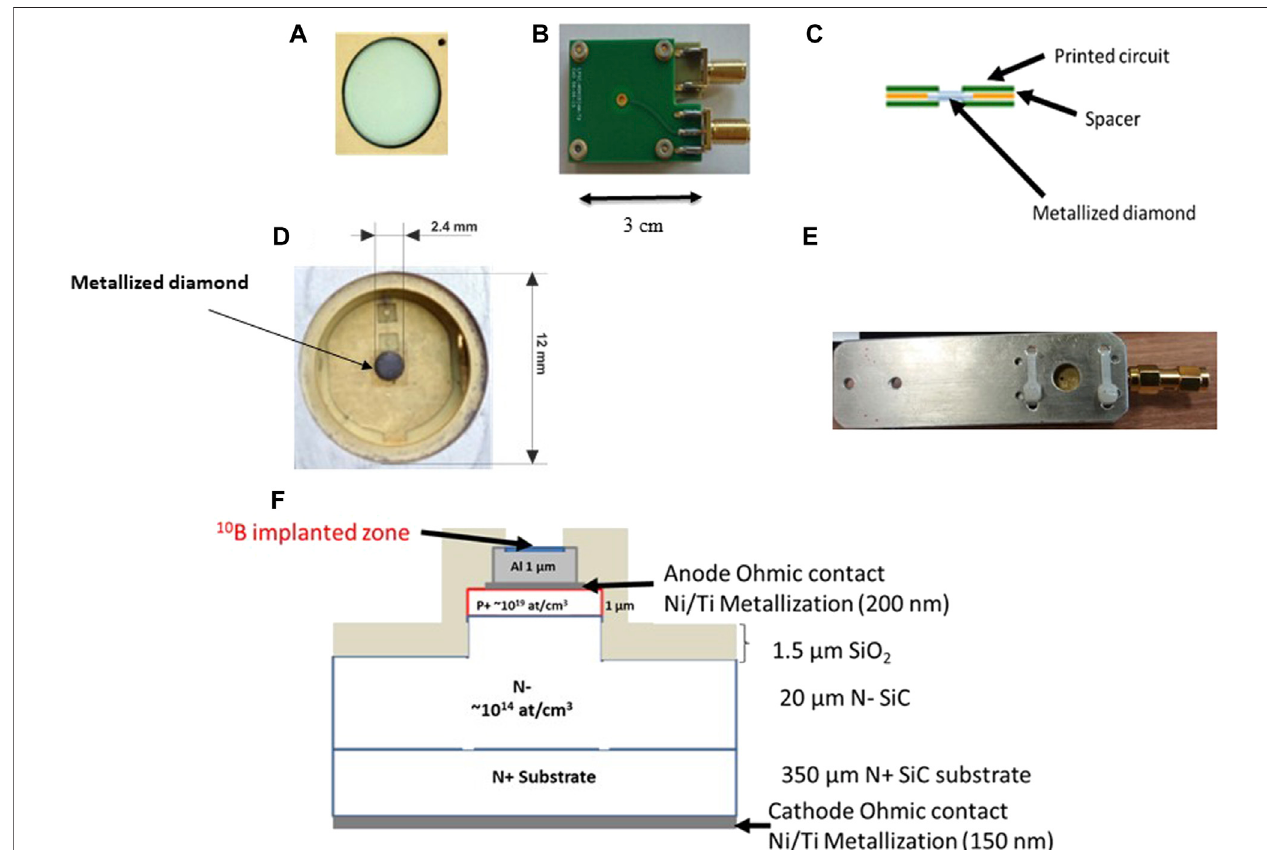
FIGURE 1 | Diamond sensor A with a disk shaped metallization (A) housed in its socket (B) according to the assembly illustrated in (C) (reproduced from [22]), (D) front side and (E) back side of diamond sensor B, 50 µm thick with contacts of 2.4 mm in diameter, (F) schematic representation of the investigated 4H-SiC-based diode.